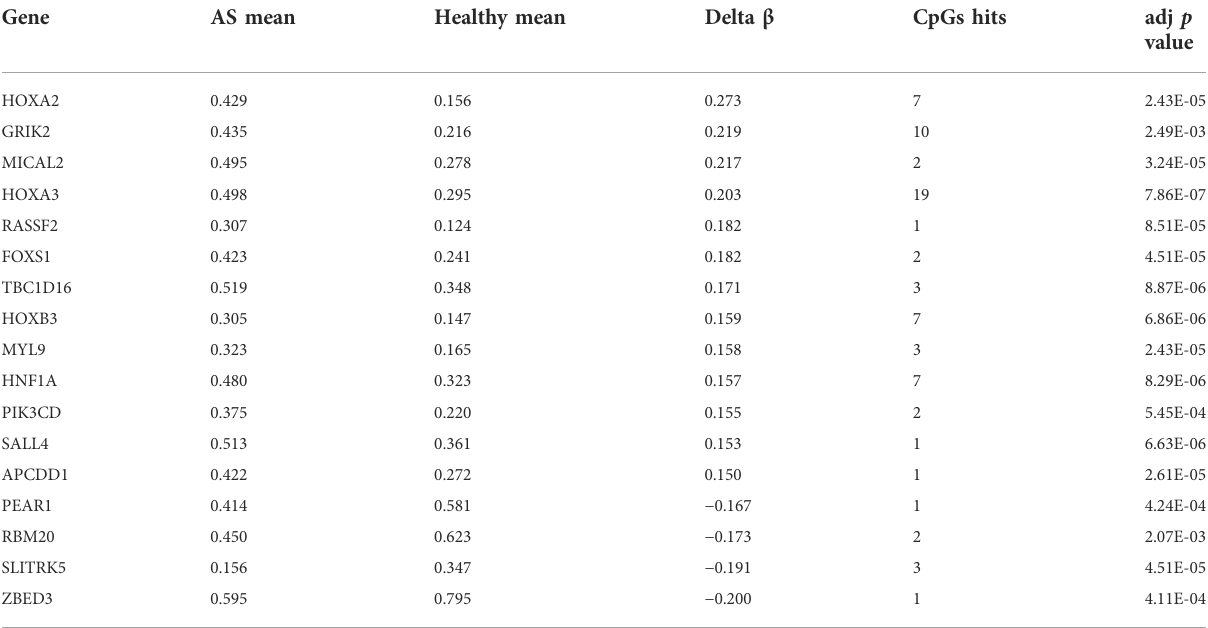
TABLE 2 Characteristics of genes with signi fi cantly difference methylation levels in